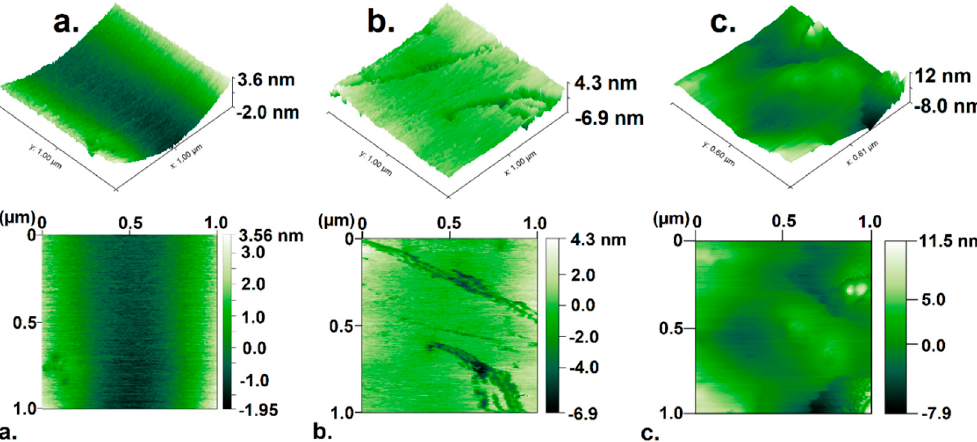
Figure 10. Atomic force microscopy (AFM) images of the (a) PEEK/Ag0.04, (b) PEEK/Ag0.08 and (c) PEEK/Ag0.12 systems with one